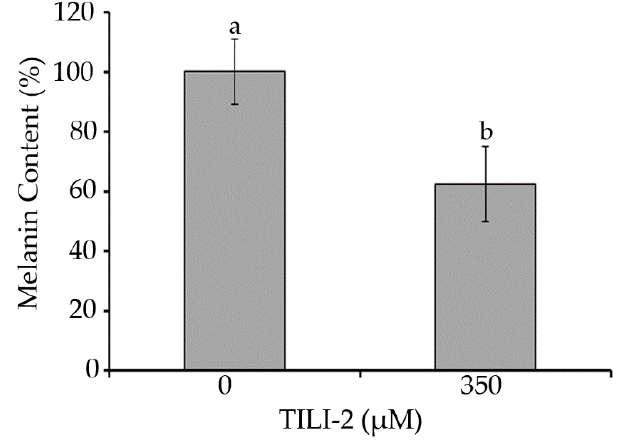
Figure 5. TILI-2 reduces melanin content. B16F1 cells were treated with TILI-2 (350 µM). All values represent the mean ± SD. Different letters indicate the significant differences from Duncan’s test ( p < 0.05).